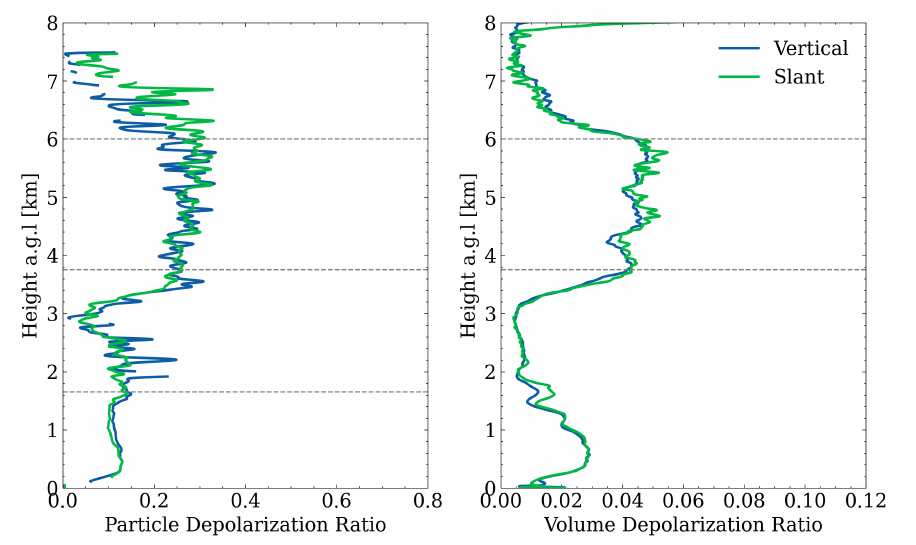
Figure 8. Volume and particle depolarisation ratio in the vertical and slant observation direction from the scanning LiDAR (KASCAL) from 19:21 to 22:54 (UTC) on 8 April